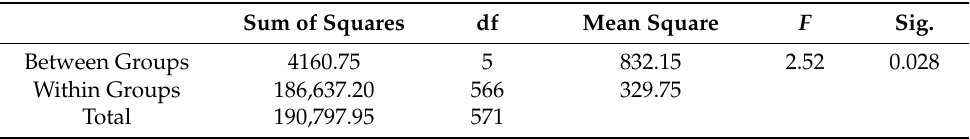
Table 4. Analysis of variance for the six wine brand identity clusters regarding average price of bottled wine. Sum of Squares df Mean Square F Sig. Between Groups 4160.75 5 832.15 0.028 Within